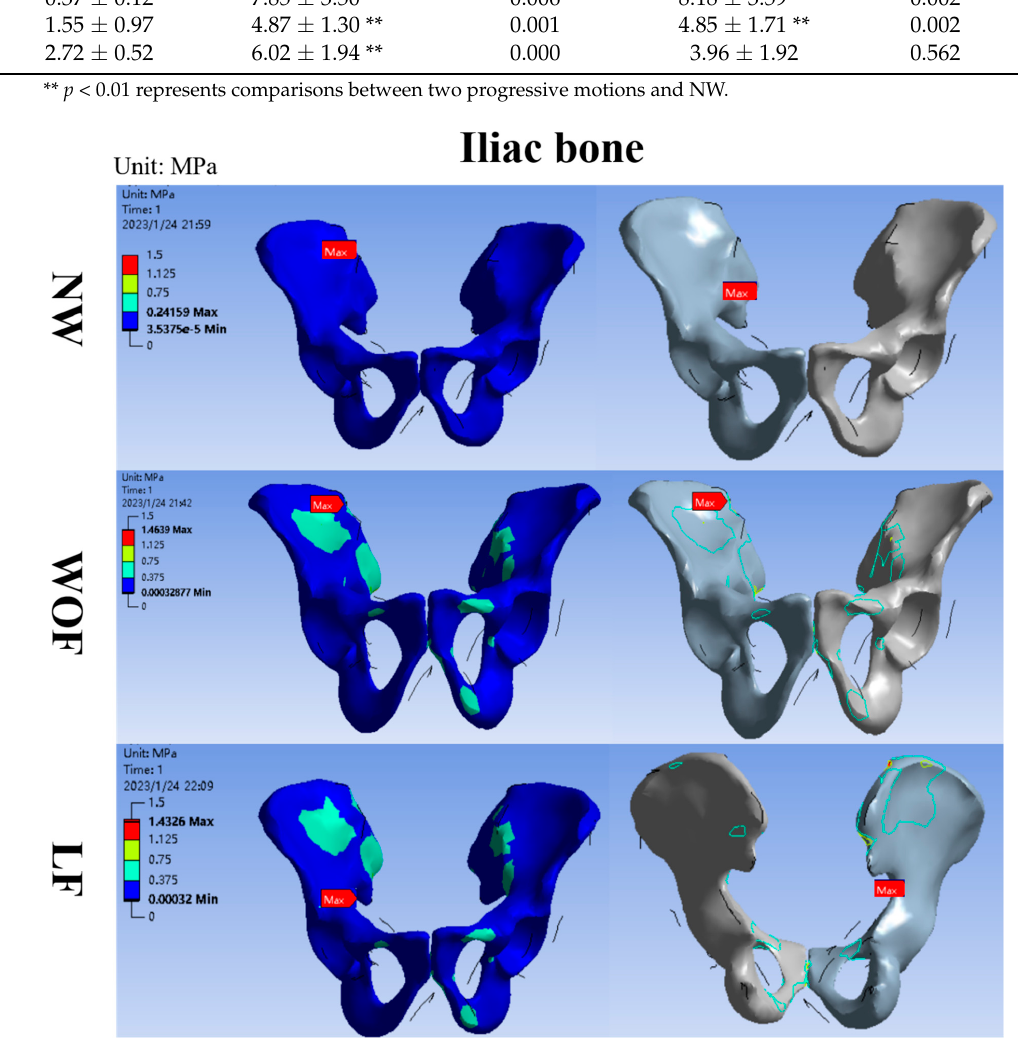
Figure 6. Mean values of stress distribution on the iliac bone during two progressive motions of Bafa Wubu and NW (NW in red; WOF in blue; LF in green).